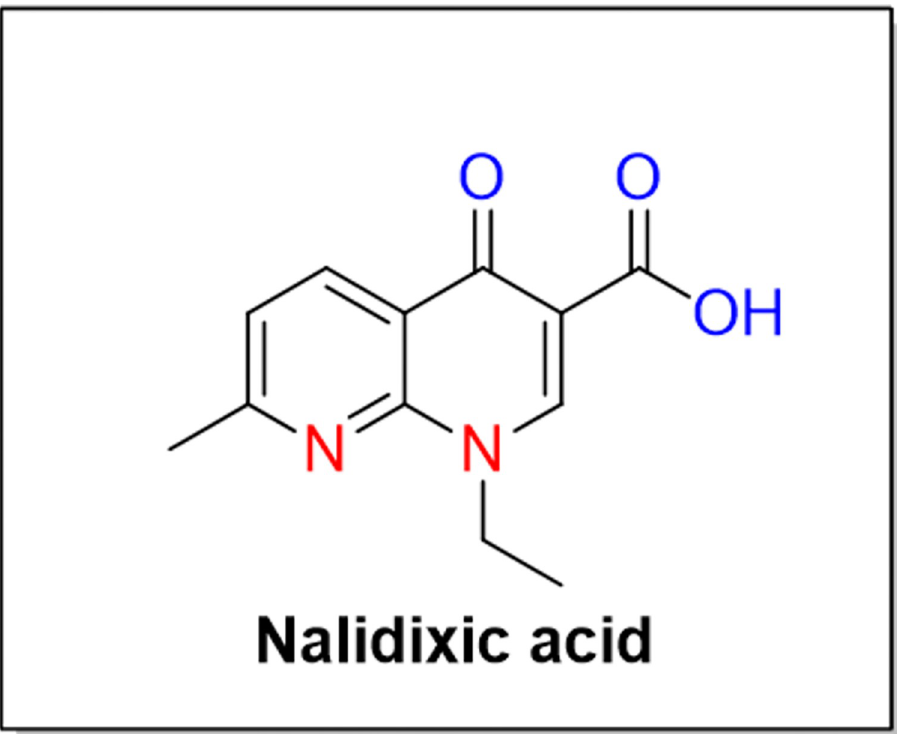
Fig 1. Structure of nalidixic acid.